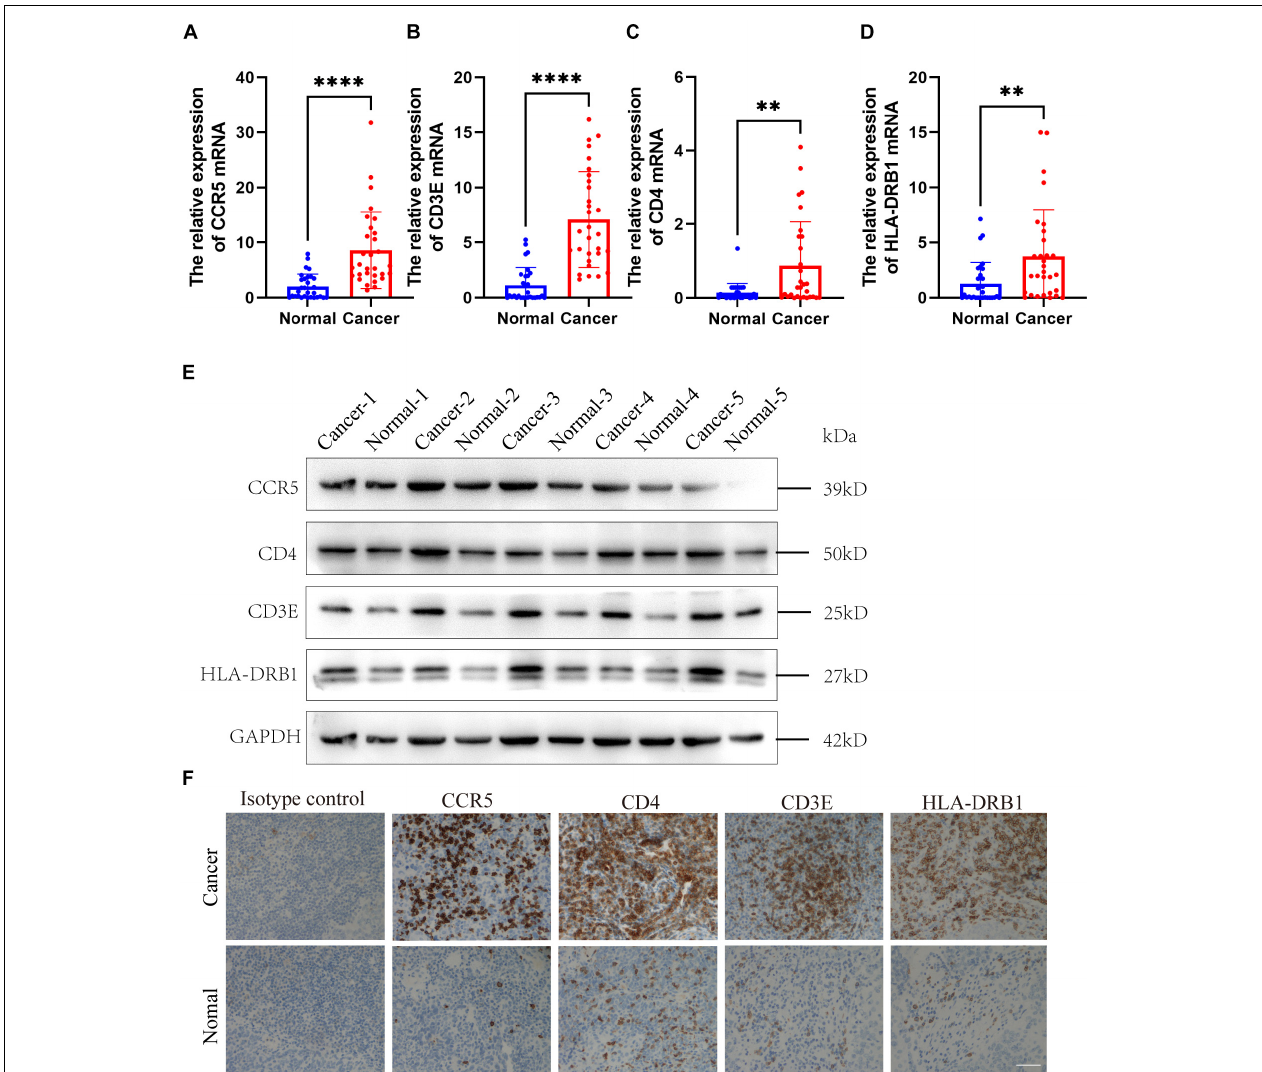
FIGURE 7 | Expression verification of four screened immune-related gene. (A–D) The mRNA levels of CCR5, CD3E, CD4, and HLA-DRB1 in HNSCC samples. (E) The protein levels of CCR5, CD3E, CD4, and HLA-DRB1 in HNSCC samples. (F) Representative immunohistochemical images of CCR5, CD3E, CD4, and HLA-DRB1. Original magnification: × 200. Bar = 50 um. ** P < 0.01, **** P <